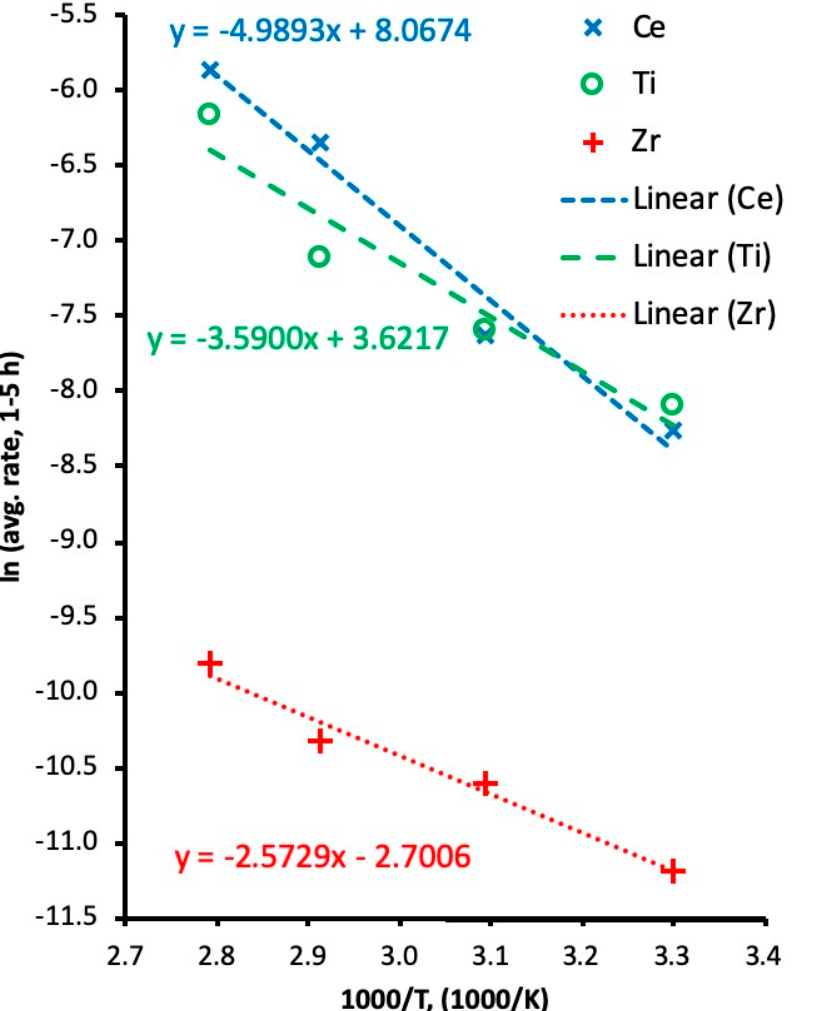
Figure 9. Arrhenius plot for Ce, Ti and Zr leaching in 0.25M H 2 SO 4 , based on the average rate of leaching from 1–5 h.